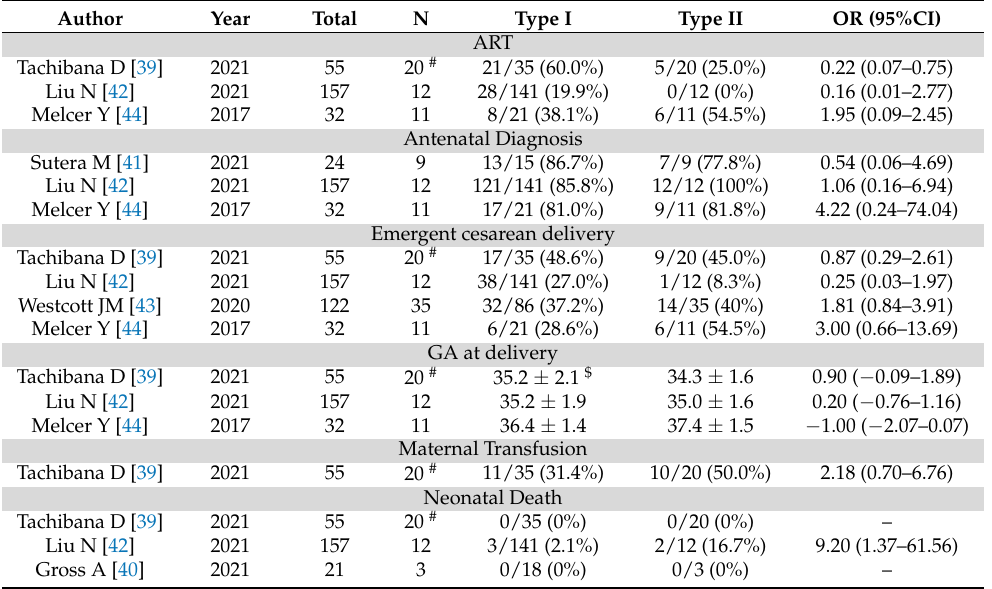
Table 2. The comparison of characteristics and outcomes between type I and type II vasa